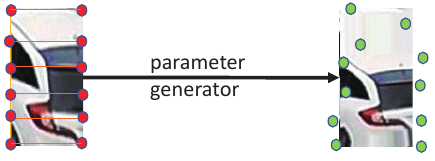
Figure 4. Overview of the Parameter Agent Network.